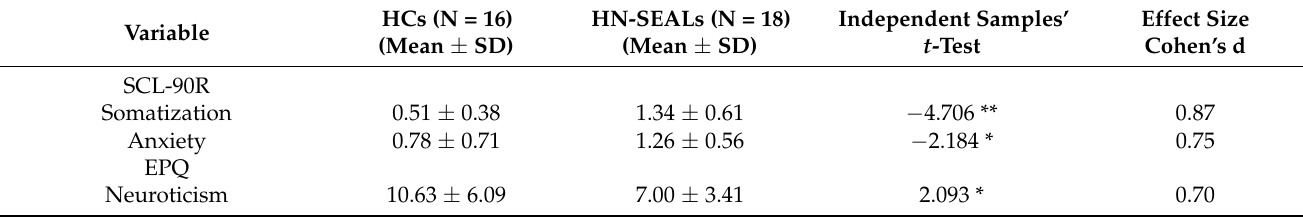
Table 2. Independent sample t -test for equality of SCL and EPQ mean values between HN-SEALs and HCs.